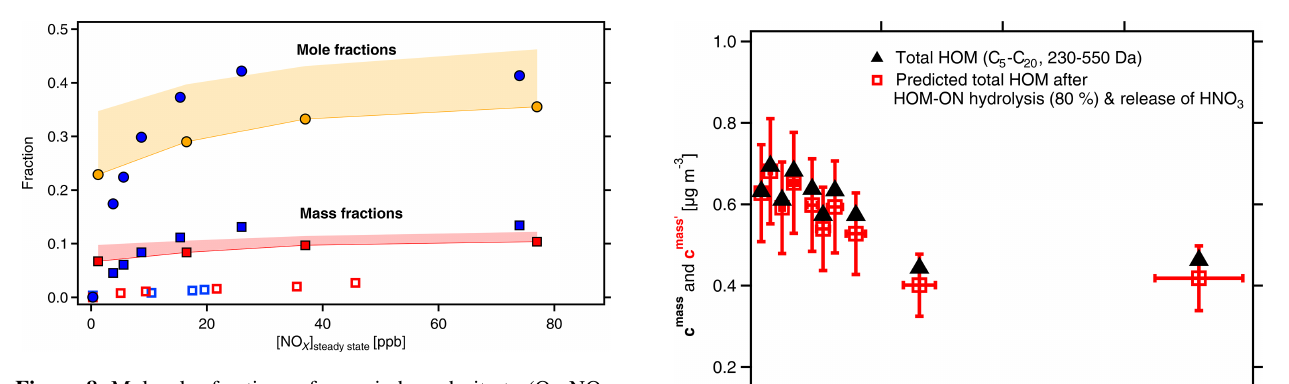
Figure 8. Molecular fractions of organic-bound nitrate (OrgNO 3 , filled circles) and mass fractions of OrgNO 3 (squares) as a function of [NO x ] SS . Data from α -pinene (blue symbols) and β -pinene (or- ange and red symbols and areas). Molecular fractions of OrgNO 3 and HOM-ONs are the same by definition. The mass fraction of OrgNO 3 in the gas phase HOMs is significantly higher than in the particulate phase as determined by AMS (open blue and red squares). The areas in orange and red give the potential error for β -pinene due to unresolved progressions and overlap of organic ni- trates with peroxy radicals (as explained in text).